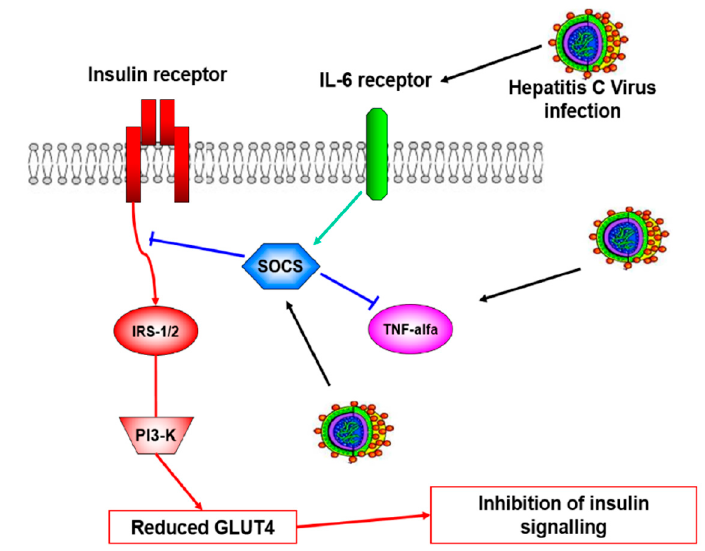
Figure 1. Theoretical explanation of the pathogenesis of hepatitis C virus-induced insulin resistance. The virus directly or indirectly, through the induction of interleukin 6 (IL-6) and/or tumor necrosis factor-alpha (TNF- 𝛼 ), determines the protoeosomal degradation of the insulin receptor substrate (IRS 1 and 2) by inducing suppression of cytokine signalling (SOCS); the consequent downregulation of phosphoinositide 3-kinase (PI3-K) causes reduced GLUT4 (glucose carrier) transmembrane expression, leading to the final inhibition of insulin signalling.